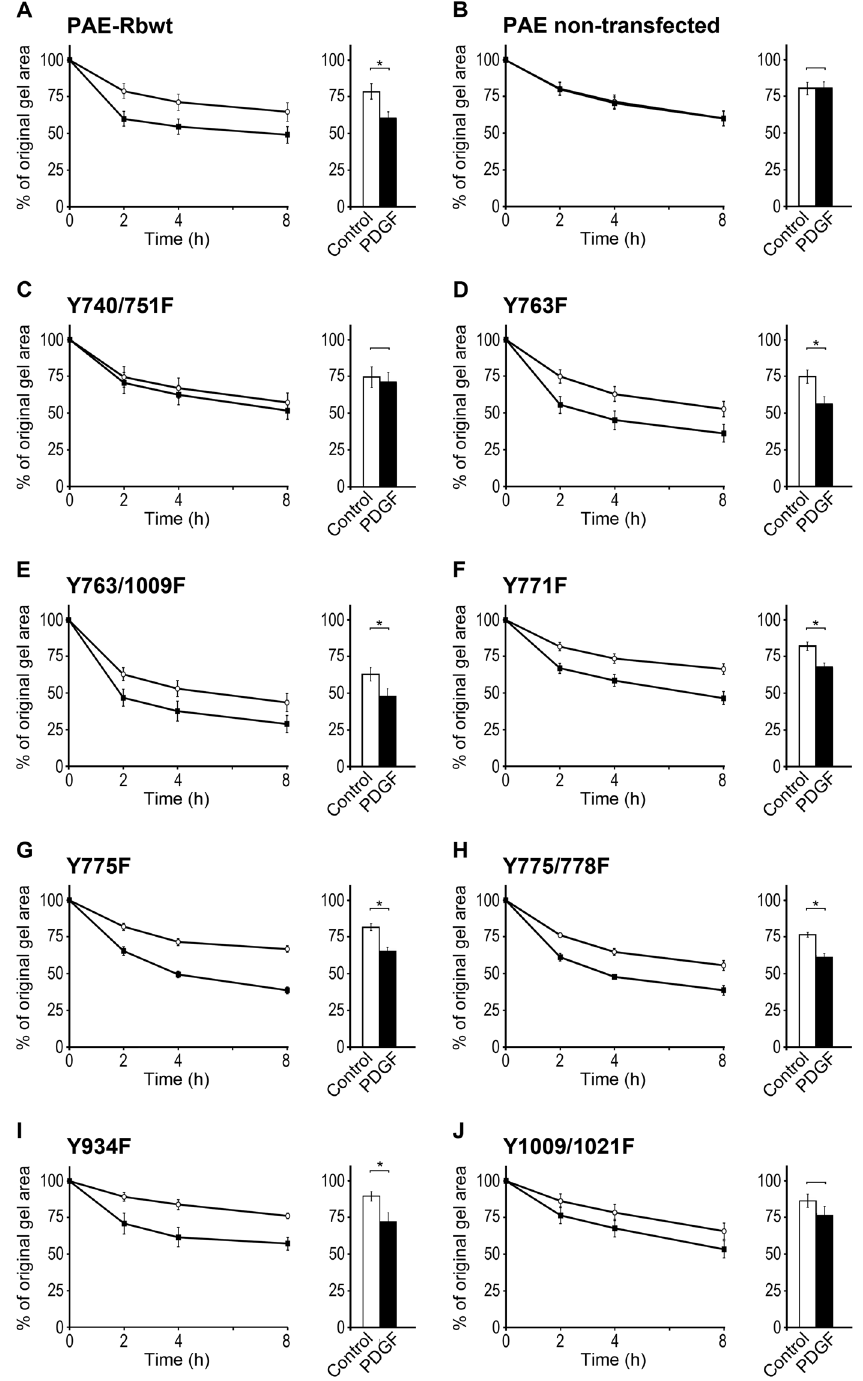
Figure 2. PI3K and PLC γ are both required for PDGF-enhanced contraction. ( A ) PAE-R β wt, ( B ) non- transfected PAE cells that lack PDGF-R β , and ( C – J ) eight PAE-R β mutants (listed in Table 1), were used in collagen gel contraction assay. Among the investigated mutant cells, only the PAE-R β Y740/751F and Y1009/1021F, the mutants that were unable to activate PI3K and PLC γ respectively, were unable to respond to PDGF stimulation by an enhanced contraction. PDGF-stimulation had no effect on non-transfected PAE cells, lacking PDGF receptors. In contrast, the PAE-R β wt (panel A) and the other six PAE-R β mutants (panels D–I) showed enhanced contraction in response to PDGF-BB. In all panels, the graph to the left presents the time- course of contraction up to 8 h and the bar chart to the right side presents the contraction after 2 h. Values are averages of a minimum of four independent experiments, each performed in triplicate. Error bars are SEM. ( * ) refers to p <